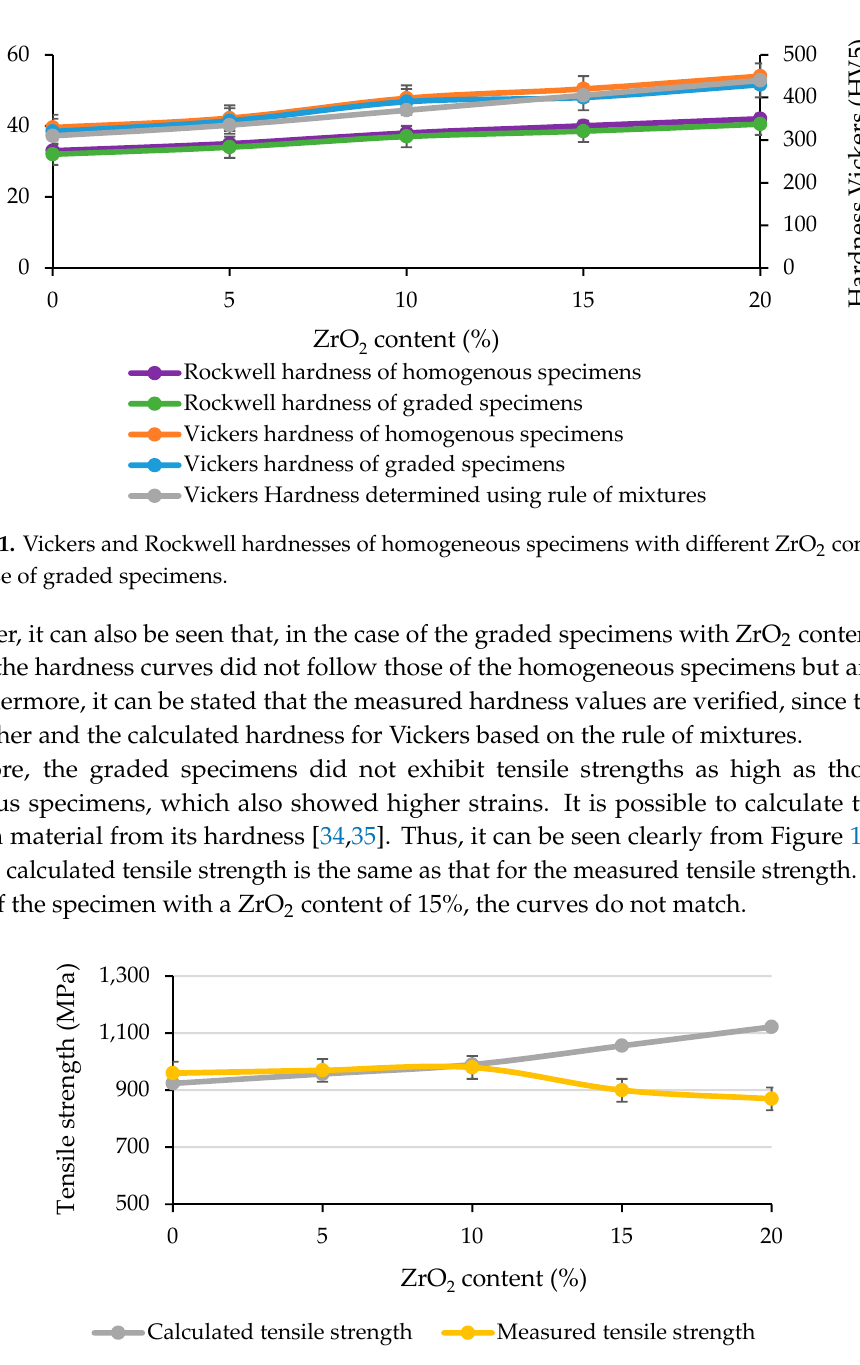
Figure 12. Calculated and measured tensile strengths for different ZrO 2 contents.